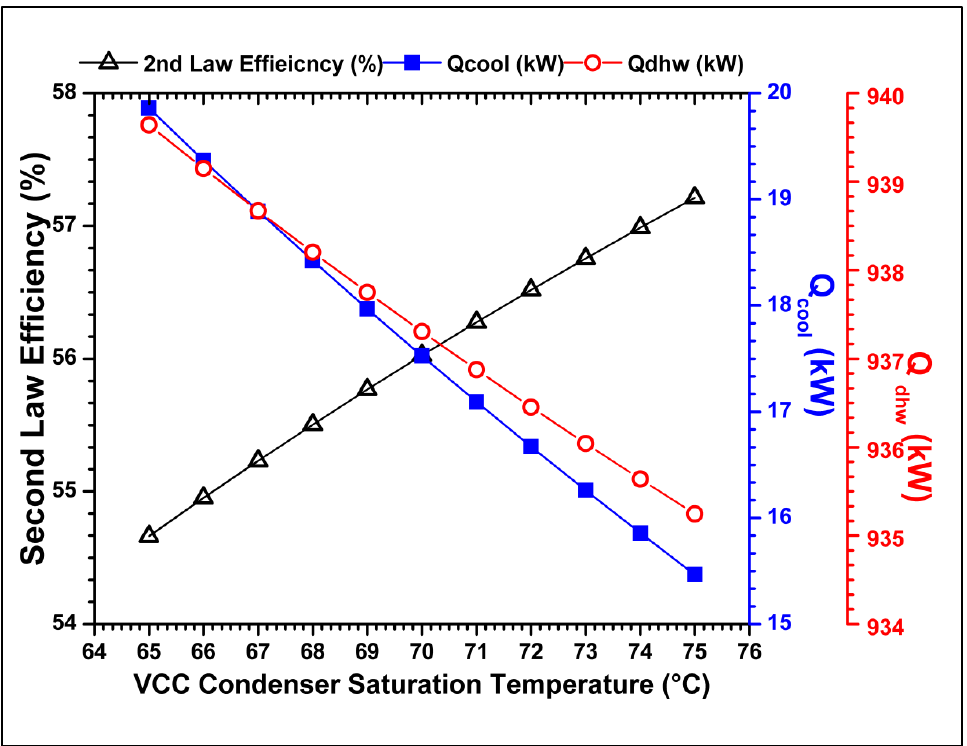
Figure 11. The variation of the cooling, heating, and second law efficiency against the saturation condensation temperature of the VCC.